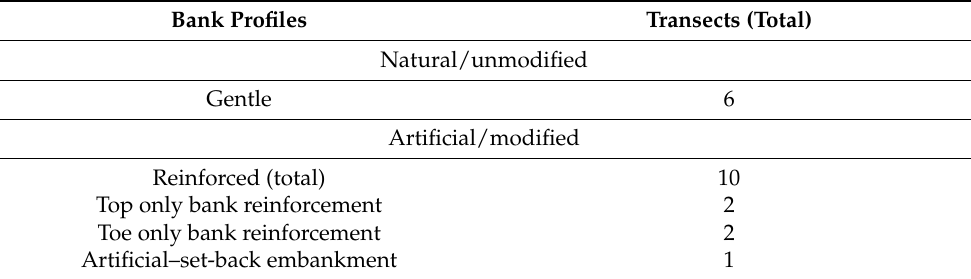
Table 6. Representativeness of observations in Section I. Bank Profiles Transects (Total) Natural/unmodified Gentle 6 Artificial/modified Reinforced (total) 10 Top only bank reinforcement 2